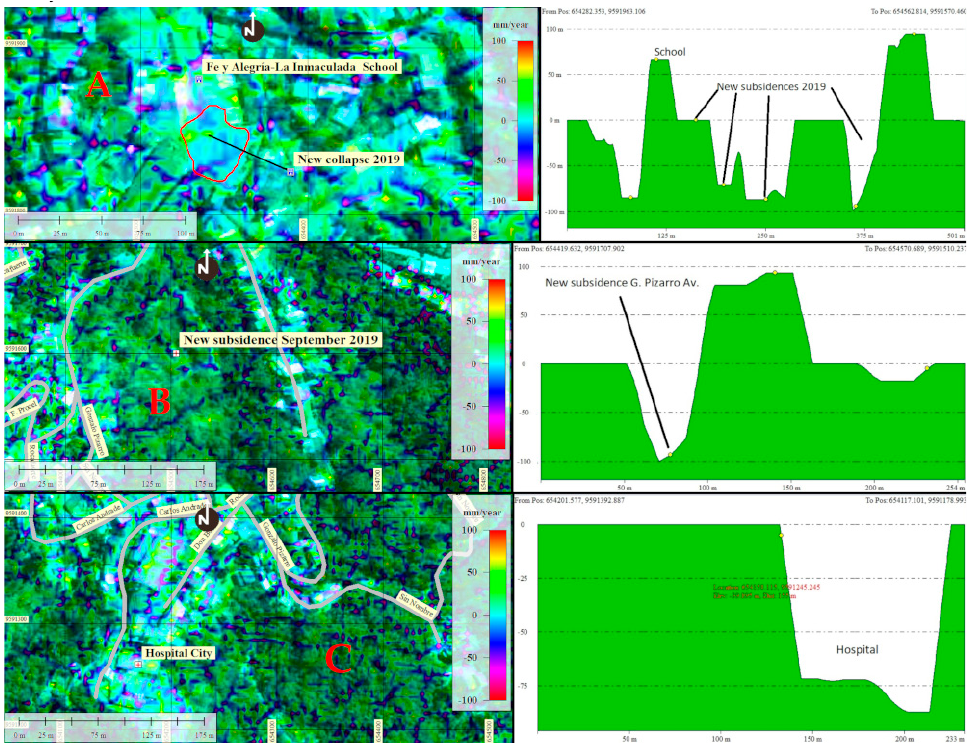
Figure 11. (A) Lifting velocity and subsidence of the ground at Fe y Alegría School ( A ), Gonzalo Pizarro Street ( B ), the city hospital( C ), obtained from the interferometric analysis. These results corroborated previous studies and verified the analysis performed in this article.